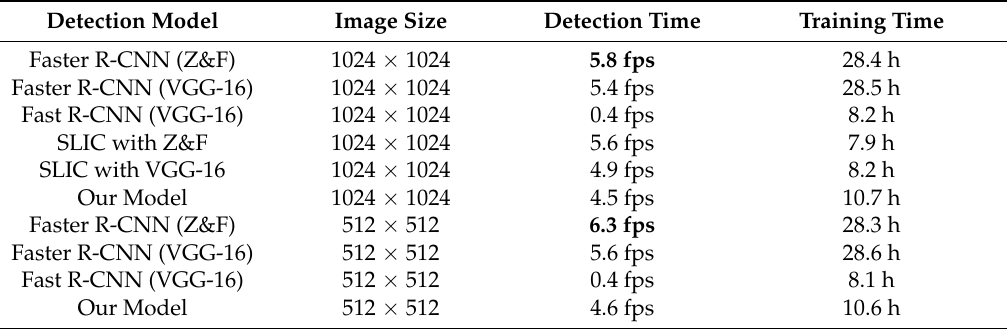
Table 3. Comparison of detection time (fps: frames per second) and training time (h: hours). Detection Model Image Size Detection Time Training Time